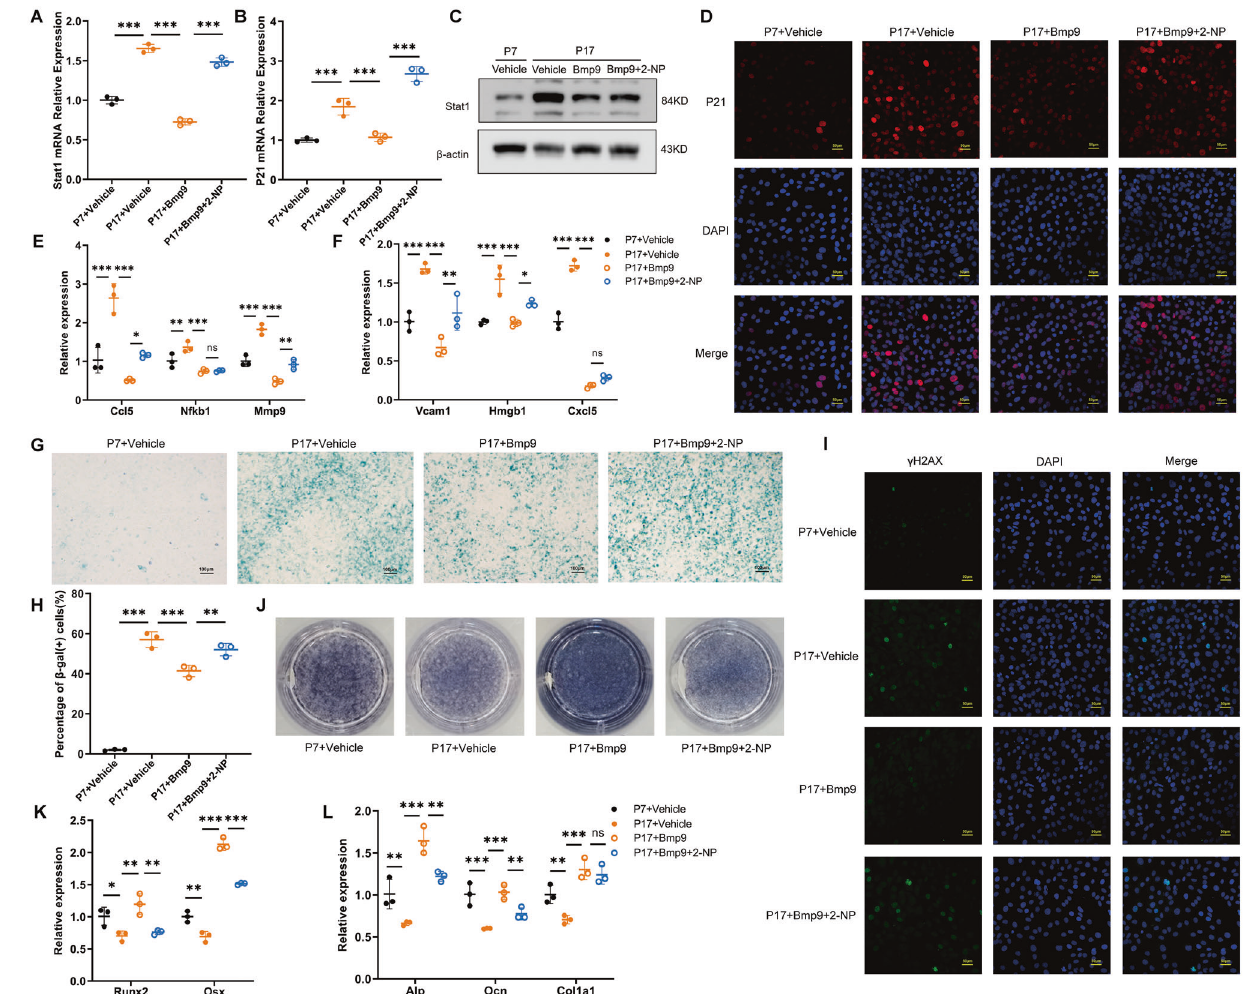
Fig. 6 The suppression of Stat1 is crucial for the anti-aging effect of BMP9 in replicative senescence of osteoblast. Passage 7 of MC3T3-E1 cells were set as control group, passage 17 of MC3T3-E1 cells were treated with vehicle or BMP9 or BMP9 + 2-NP for 3 days, respectively. A , B qPCR analysis of Stat1 and P21 expression. C Western blot analysis of protein level of Stat1. D Immuno fl uorescence analysis of protein level of P21. (Scale bar, 50 μ m). E , F qPCR analysis of mRNA levels of SASPs. G , H β -galactosidase staining was performed ( G ) and number of β -gal ( + ) cells was counted for each group ( H ) (Scale bar, 100 μ m). I Immuno fl uorescence analysis of γ -H2AX expression (Scale bar, 50 μ m). J Alp staining of MC3T3-E1 cells suffered to osteogenic differentiation induction for 7 days. K , L qPCR analysis of mRNA levels of osteoblastic differentiation markers. Data presented as mean ± SD. n = 3 biological replicates. One-way ANOVA was used for comparison among multiple groups. * P < 0.05; ** P < 0.01; *** P < 0.001. Ns, no signi fi